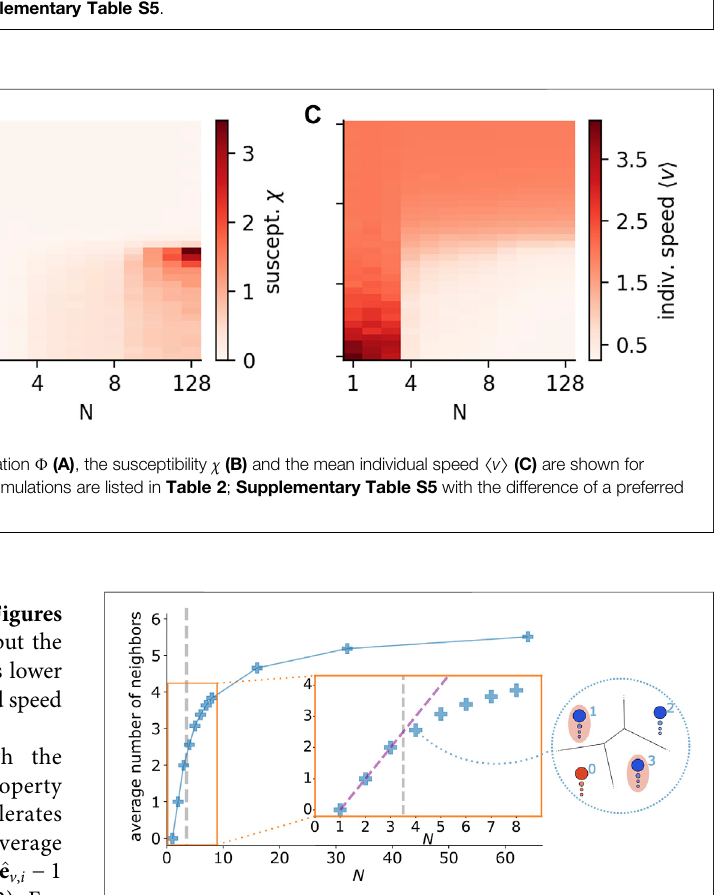
FIGURE 6 | Qualitative topological change with group size. Average Voronoi neighbor number for different group sizes. The dashed purple line (inset)marksthenumbersofneighborsofafullyconnectedgroup.Illustrations of a typical spatial constellation for a group of size N (cid:1) 4. The focal agent (0),itsneighbors(1,3)andanagentthatisnotconnectedtothefocalagent(2) are shown. Note that only for group sizes N > 3 the latter exists, which hampers directional synchronization of the collective. The parameters of the simulations are listed in Table 2 ; Supplementary Table S5 with the difference of a preferred speed of v0 (cid:1)